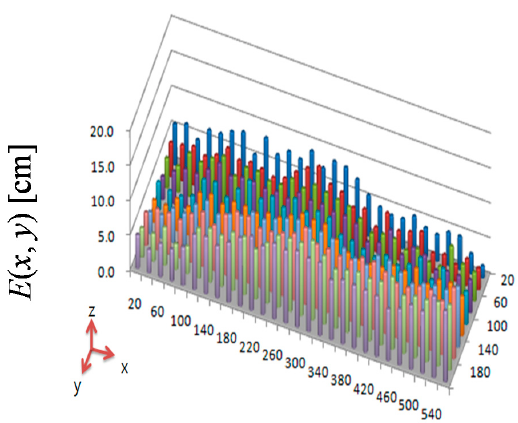
Sensors 2016 , 16 , 195 9 of 13 Figure 15. Position error estimate. (cid:1876) (cid:3032) (cid:3404) (cid:1876) (cid:3045)(cid:3032)(cid:3028)(cid:3039) (cid:3398) (cid:1876) (cid:3040)(cid:3032)(cid:3028)(cid:3046)(cid:3048)(cid:3045) , (cid:1877) (cid:3032) (cid:3404) (cid:1877) (cid:3045)(cid:3032)(cid:3028)(cid:3039) (cid:3398) (cid:1877) (cid:3040)(cid:3032)(cid:3028)(cid:3046)(cid:3048)(cid:3045)